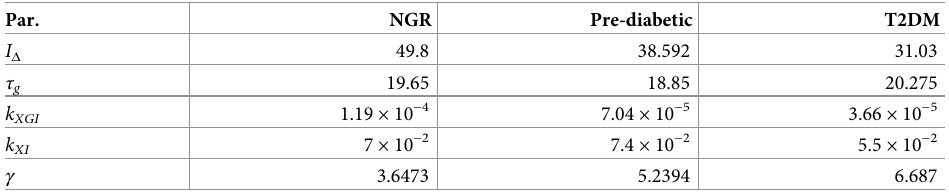
Table 2. Compact Model parameter estimates for a NGR, pre-diabetic and T2DM virtual patient (see Figs 4, 5 and 6). Par.